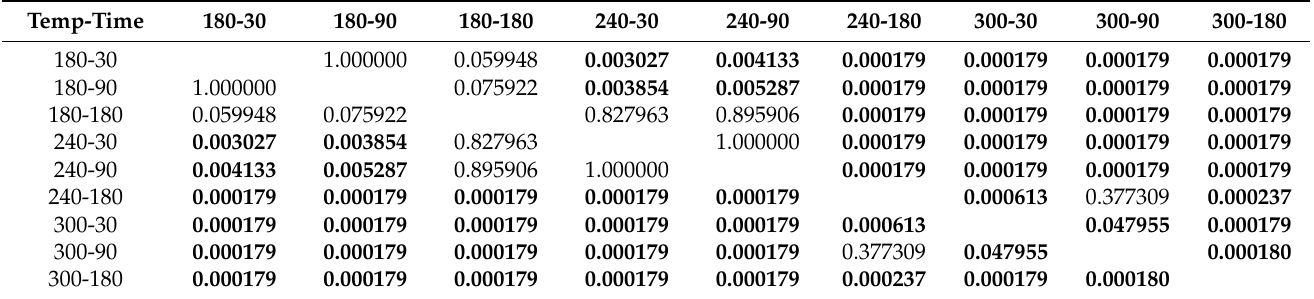
Table A3. Two-way analysis of variance (ANOVA) with post hoc Tukey test for FR , a bold font signifies a statistically significant difference ( p < 0.05).